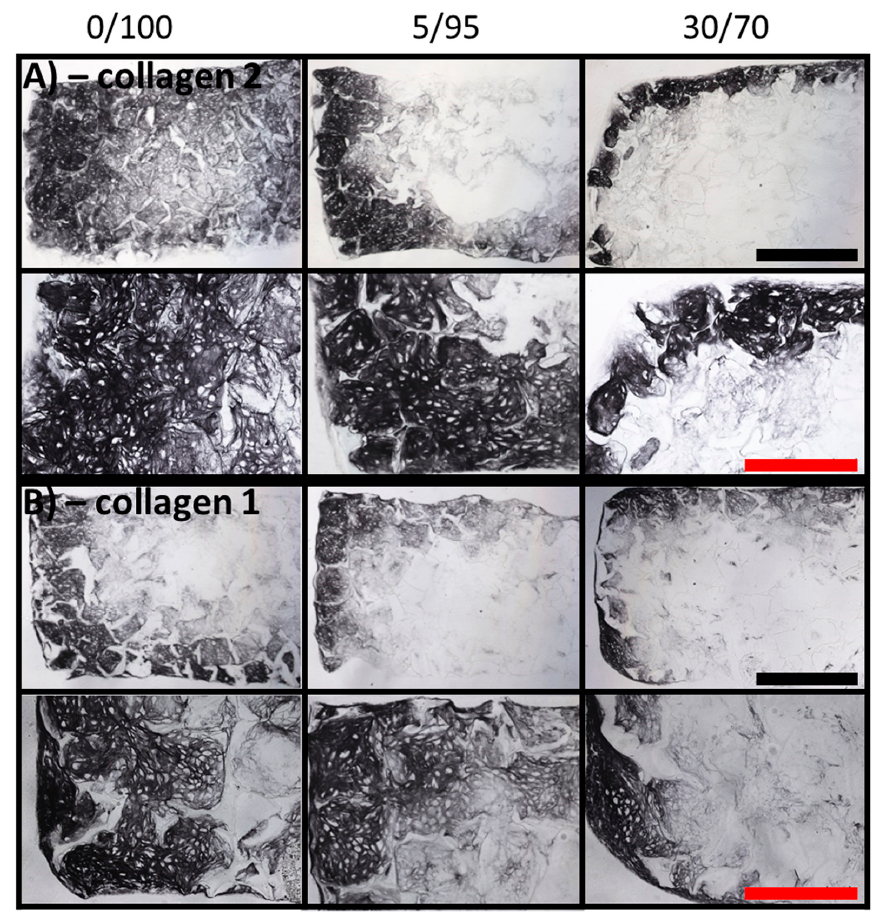
Figure 6. Immunohistochemistry of MSC-seeded scaffolds of different composition (columns) after 21 days of culture in chondrogenic medium. ( A ) Immunohistochemistry for collagen 2 at ×4 magnification (upper row, black scale bar = 1 mm) and ×10 magnification reveals more collagen 2 deposition in 0/100 scaffolds than in 30/70 scaffolds (red scale bar = 500 µm). Best samples are shown; ( B ) Immunohistochemistry for collagen 1 at ×4 magnification (upper row, black scale bar = 1 mm) and ˆ 10 magnification reveals no major differences of collagen 1 deposition between the three tested scaffold compositions; best samples are shown (red scale bar = 500 µ